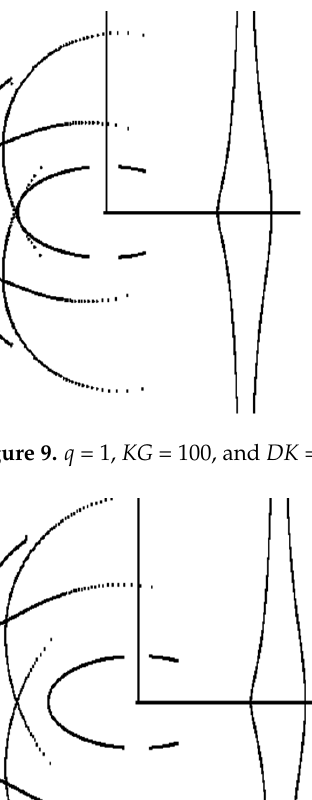
Figure 8. q = 1, KG = 60, and DK = 220.